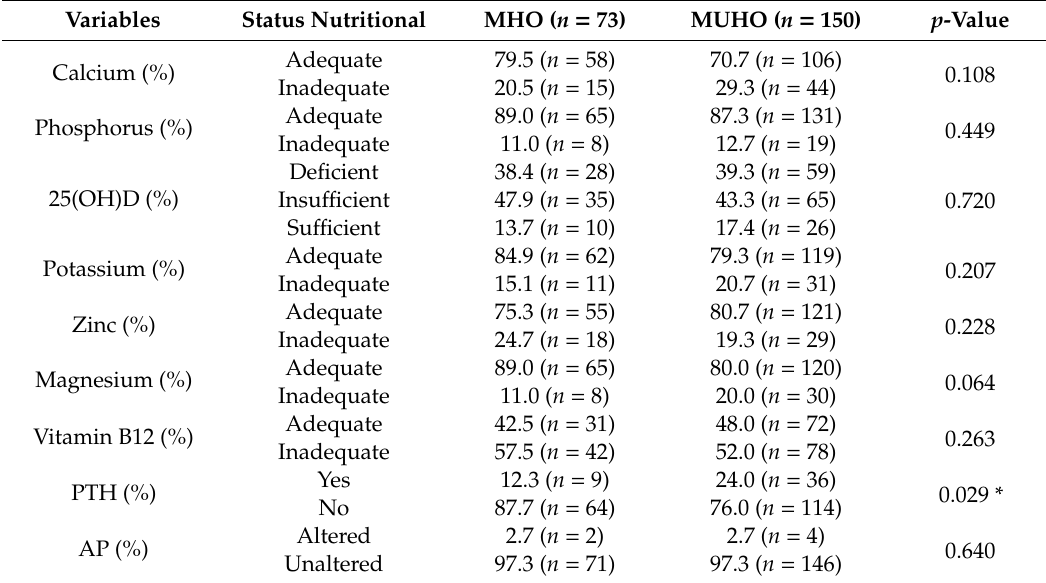
Table 3. Association between markers and micronutrients of bone metabolism according to the MHO and MUHO